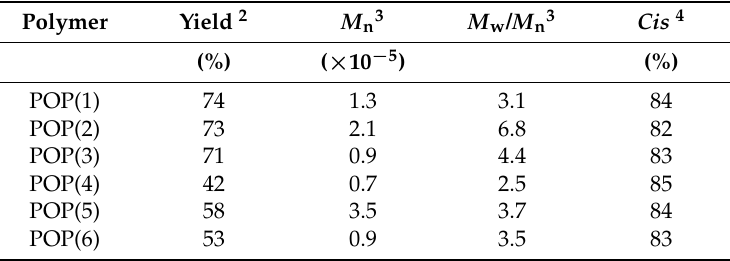
Table 1. Synthesis of poly(oxyethy propiolate)s using a [Rh(nbd)Cl] 2 catalyst in MeOH 1 . Polymer Yield 2 M